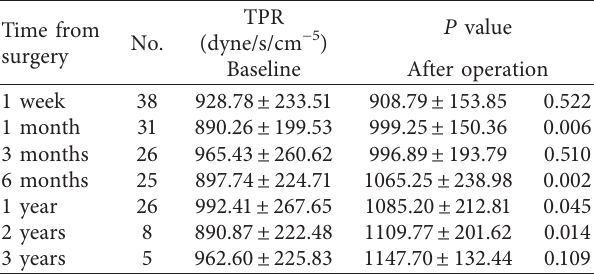
Table 5: Comparison of total peripheral resistance (TPR) at baseline and postoperatively in liver cirrhosis